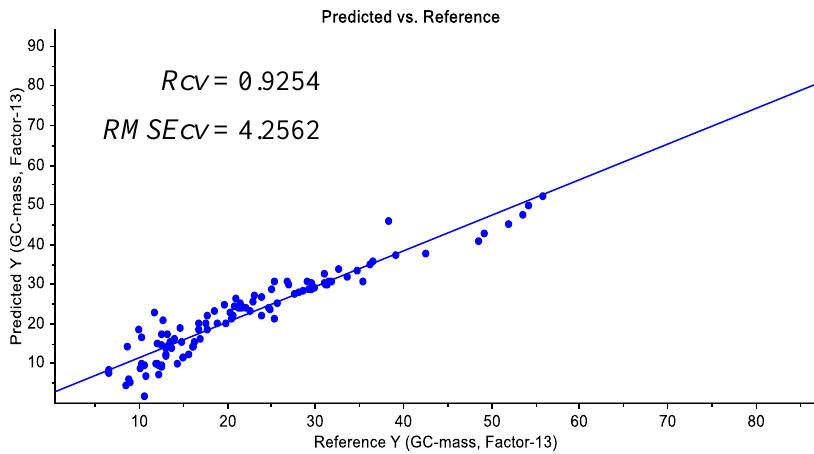
Figure 6. Predicted residual pesticide values versus reference values.